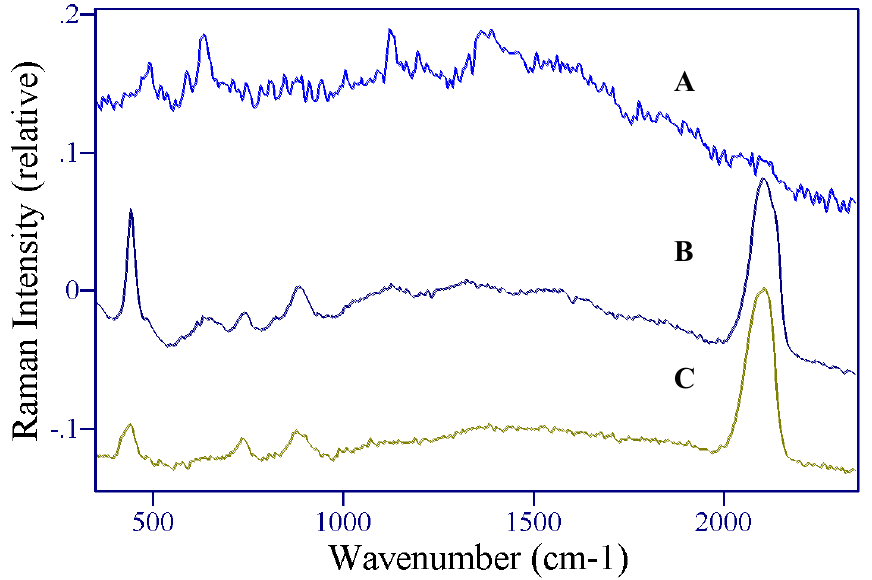
Figure 12. SER spectra of A) saliva-1, B) saliva-2, and C) KSCN. Conditions: 1 mg/mL, 100 mW of 785 nm, 1 min. Note the top spectrum was multiplied by 10 so features could be